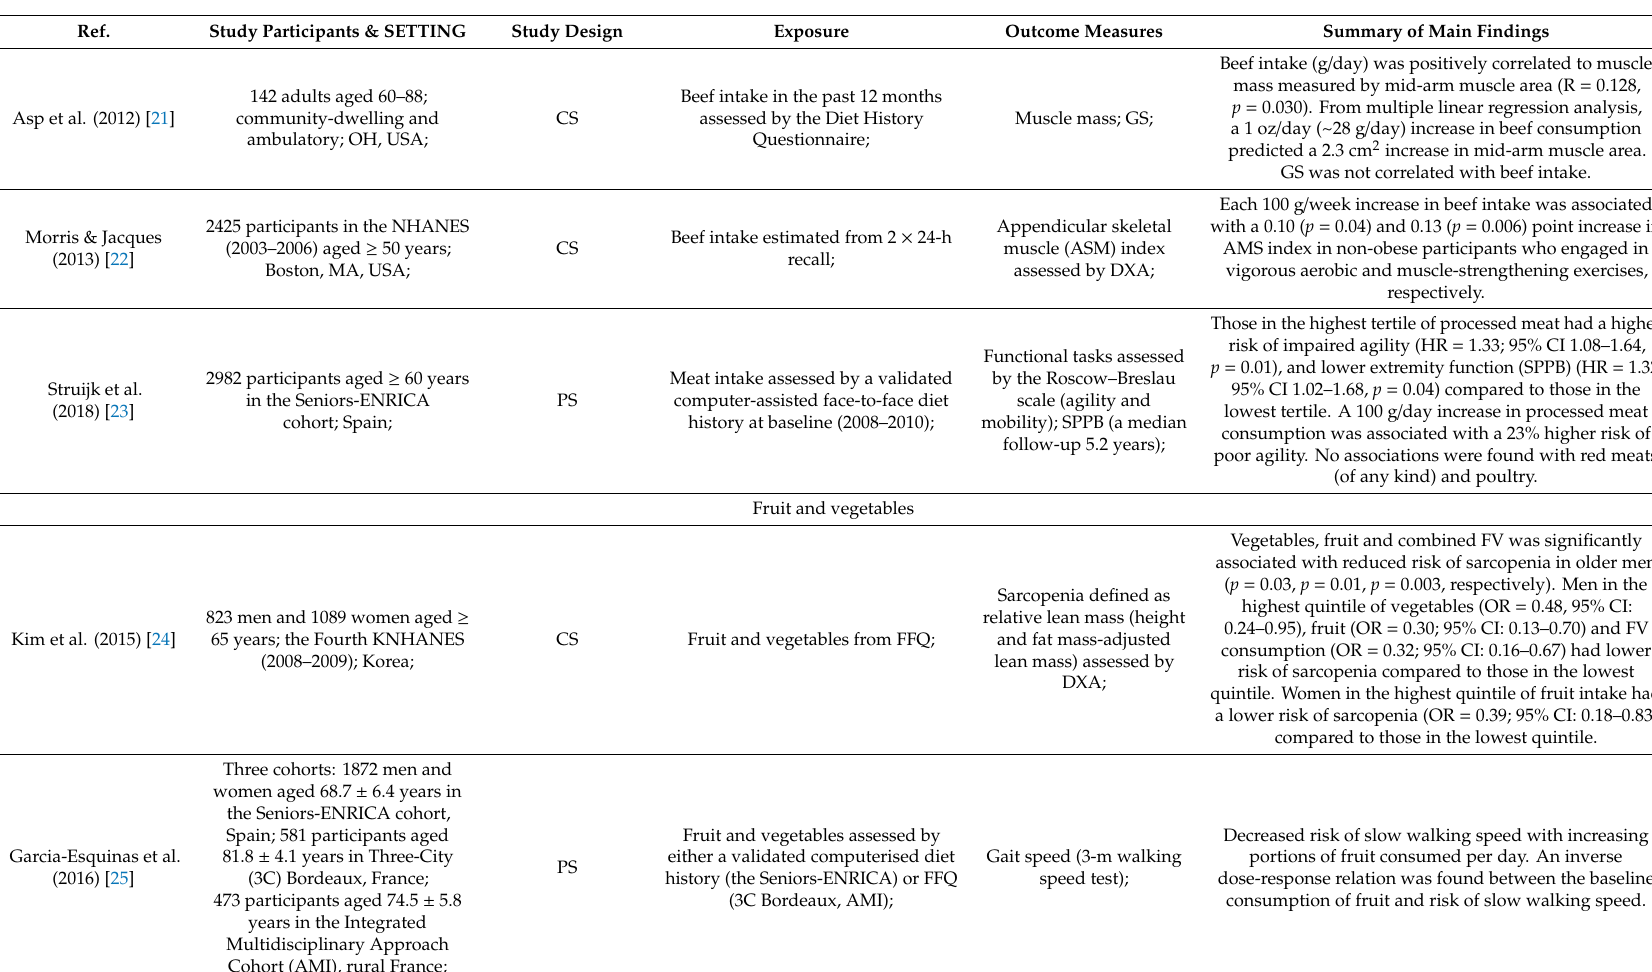
Table 1. Observational studies involving whole foods and muscle-related outcomes in older adults aged ≥ 50